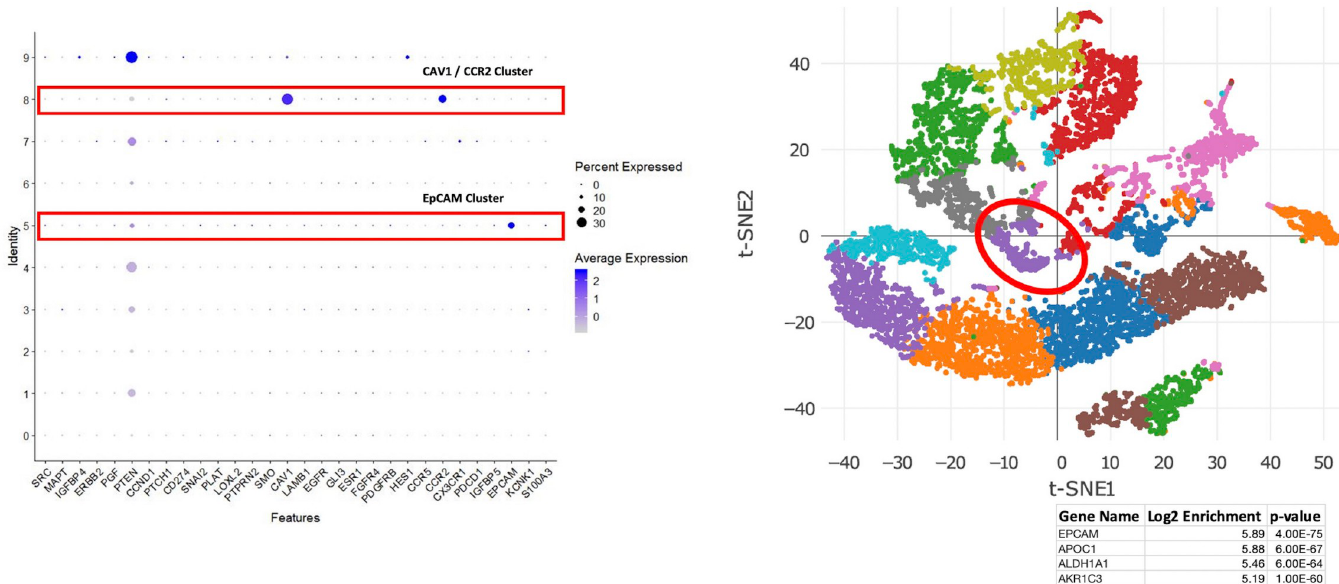
Fig 6. ( Left ) Expression of DTC gene panel across cell clusters from TNBC BM sample. ( Right ) tSNE plot highlighting the EPCAM-specific cluster (2% of the cell population) and list of most significant, differentially expressed transcripts in that cluster.